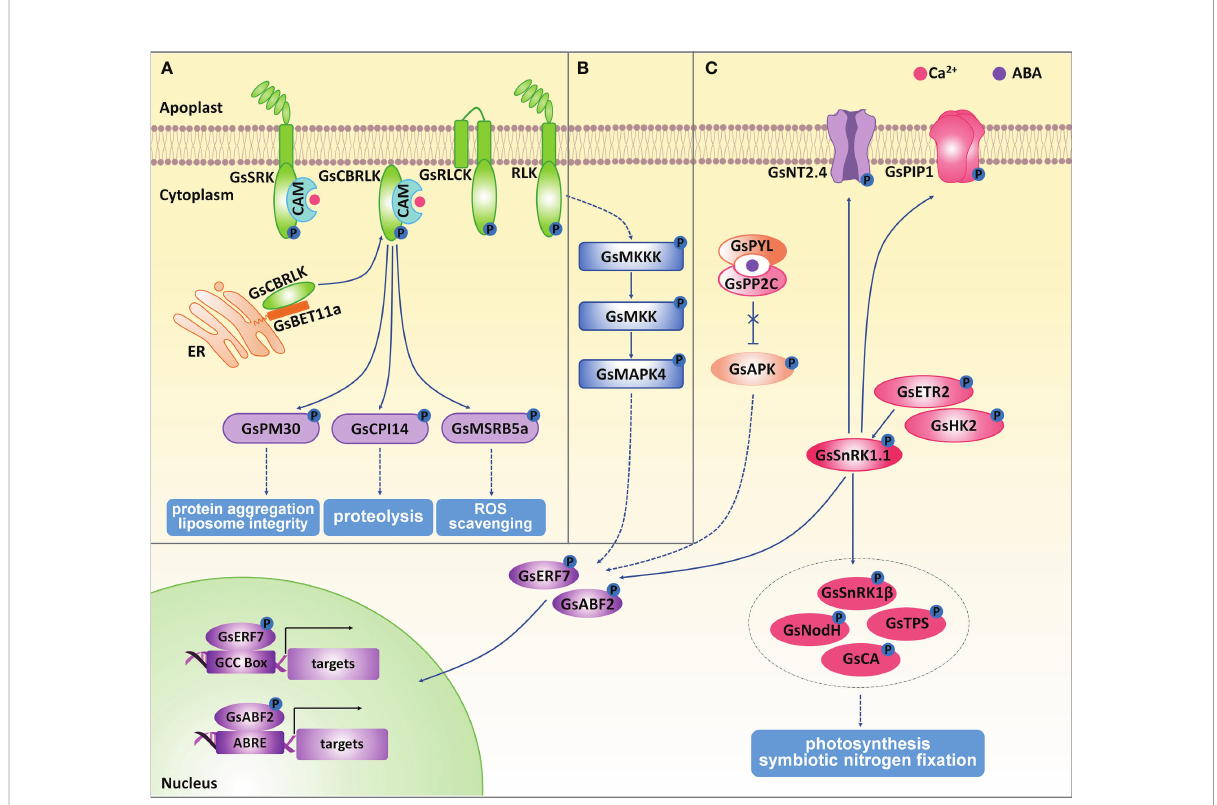
FIGURE 3 The regulation of protein kinases on wild soybean response to salt-alkaline stress. (A) Receptor like kinases, (B) MAPK kinases, (C) SnRK kinases mediated stress response in G. soja under salt-alkaline stress. ER, endoplasmic reticulum. Solid lines represent direct physical interaction, and dotted lines represent indirect interaction or results. Arrows represent positive effects, and lines ending with a short bar indicate negative